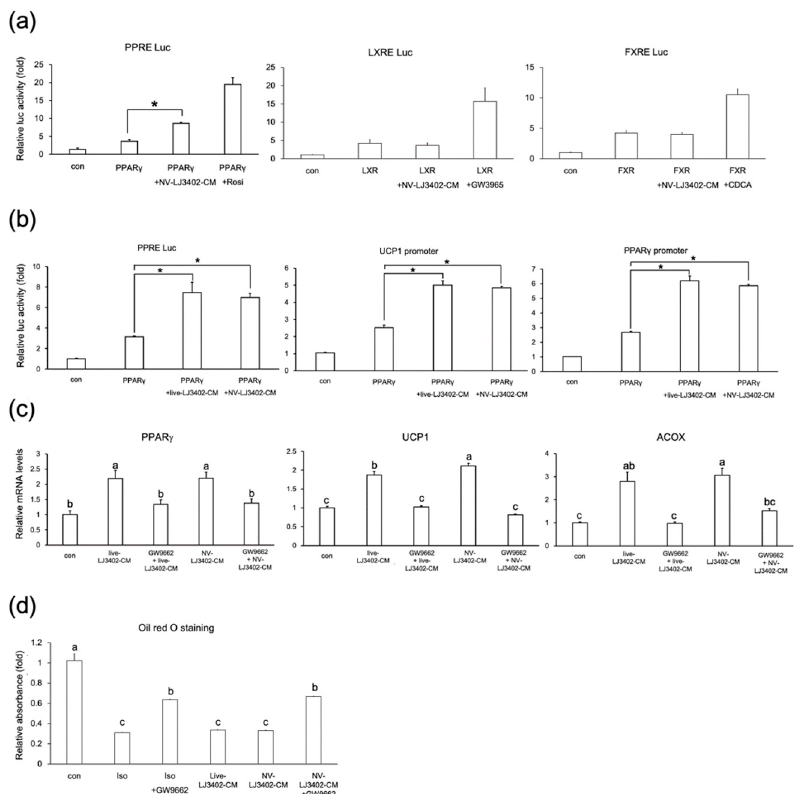
Figure 3. E ff ect of NV-LJ3402 on the activities of transcription factors important for metabolic gene expression ( a ) HEK293T cells were co-transfected with di ff erent metabolic transcription factors (PPAR γ , liver X receptor, LXR or farnesoid X receptor, FXR) and appropriate reporter genes harboring their cognate response elements (pGL3-ACOX-PPRE-Luc, PPRE Luc, pGL3-CETP-LXRE-luc, LXRE Luc or pGL3-TK-IR-1-Luc, FXRE Luc), as indicated. After 12-h transfection, cells were incubated for 24 h